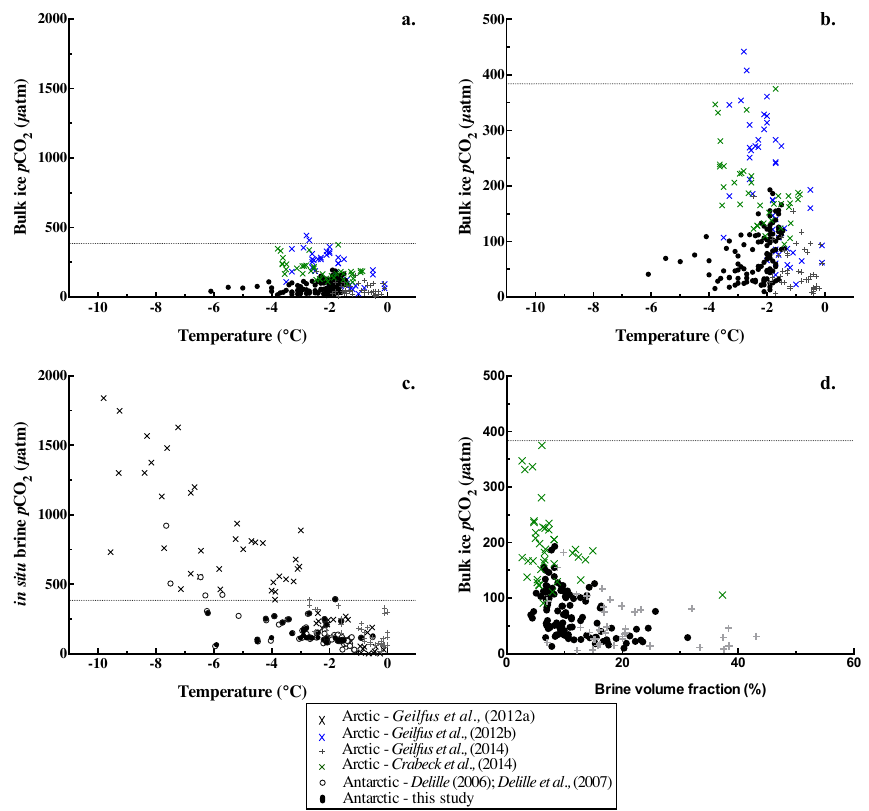
Figure 10. (a) The relationships between bulk ice p CO 2 (in µatm) and temperature measured in Antarctic (this study) and Arctic (Geilfus et al., 2012b, 2014; Crabeck et al., 2014) sea ice; (b) zoom-in on the data from (a) ; (c) the relationships between in situ brine p CO 2 (in µatm) and brine temperature in the Antarctic (this study; Delille, 2006; Delille et al., 2007) and Arctic sea ice (Geilfus et al., 2012a); (d) relationship between the bulk ice p CO 2 (in µatm) and the brine volume fraction (in %) measured in Antarctic (this study) and Arctic (Geilfus et al., 2012b, 2014; Crabeck et al., 2014) sea